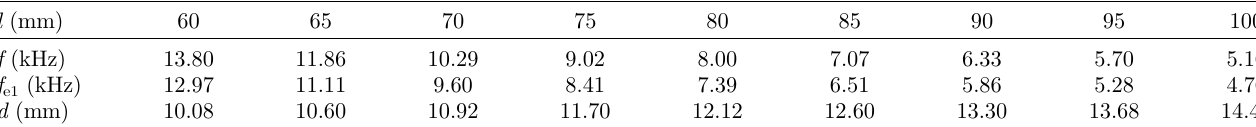
Table 2. Relation between the rhombus mode and the thickness of plate.